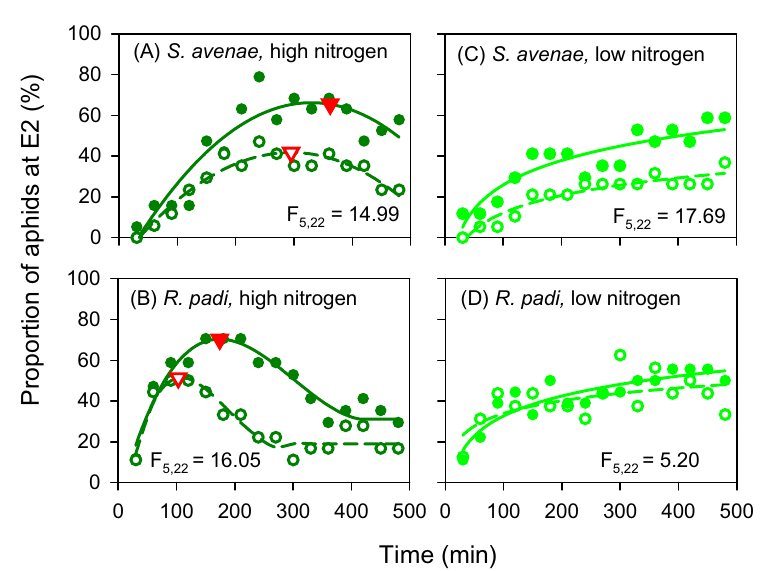
Figure 5. First two linear discriminants of the multivariate EPG data for the complete set of samples (16 ≤ n ≤ 19) across the combination of nitrogen (n, low; N, high), [CO 2 ] (400 and 700 ppm) and aphid species (Rp, Rhopalosiphum padi; Sa, Sitobion avenae ). The first linear discriminant explained 60.8% of the variation and the second discriminant explained 9.5%. The multivariate EPG data comprises 19 variables, after accounting for both non-zero values and redundancy in the complete set of variables.